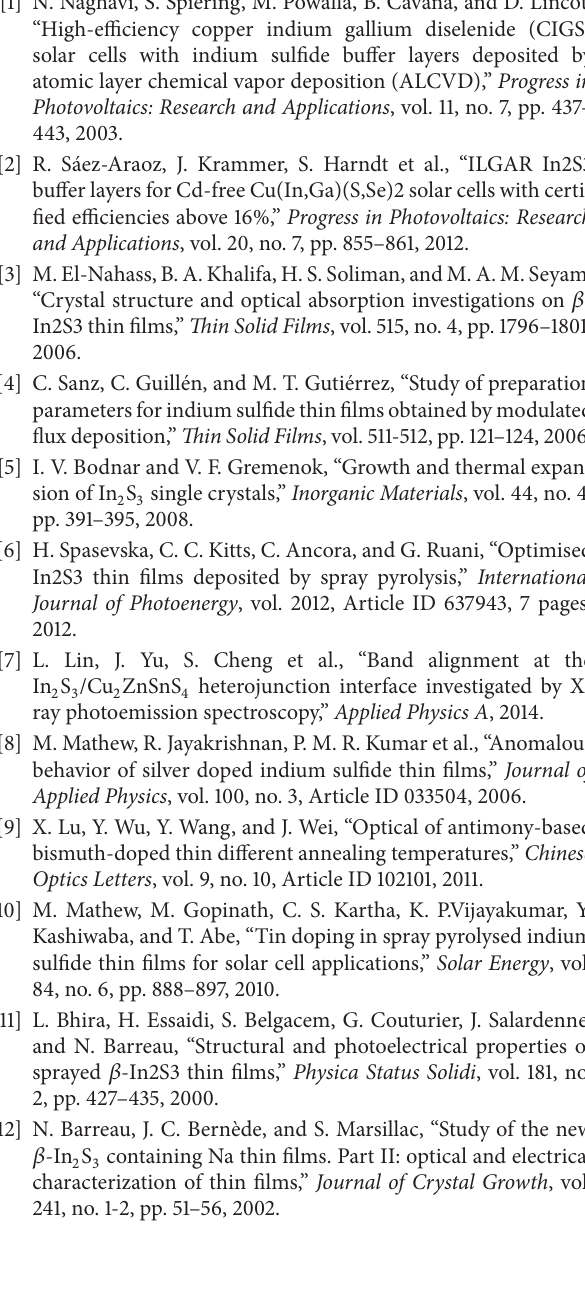
S :Ag films with different 2 3